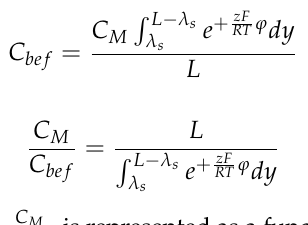
for various (cid:2923)(cid:2925)(cid:2922) for various m 3 (cid:2923) (cid:3119)